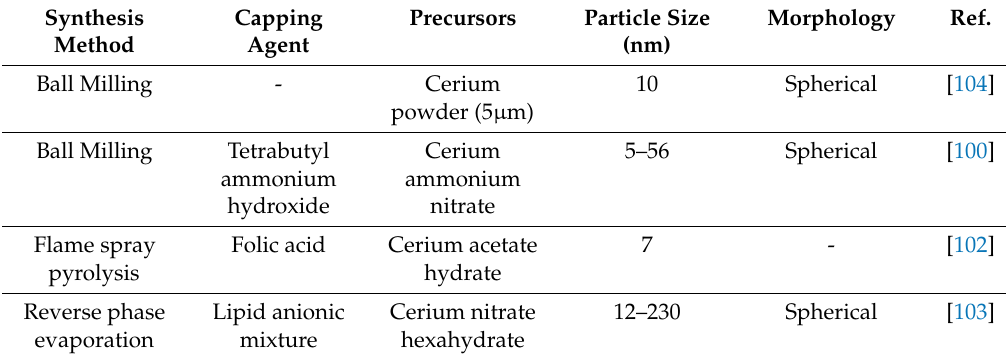
Table 7. Table showing the synthesis of cerium oxide nanoparticles using the various synthesis